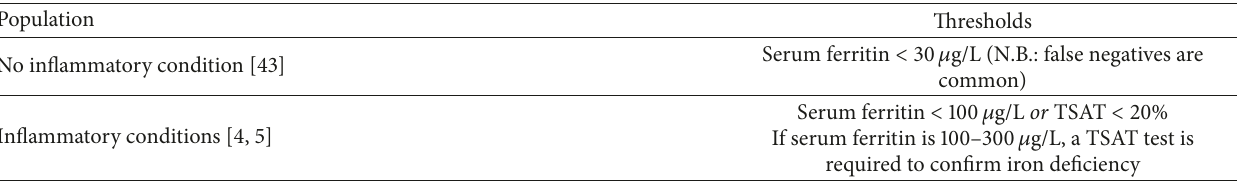
Table 2: Proposed serum ferritin and TSAT thresholds for the diagnosis of iron deficiency in patients with or without inflammatory